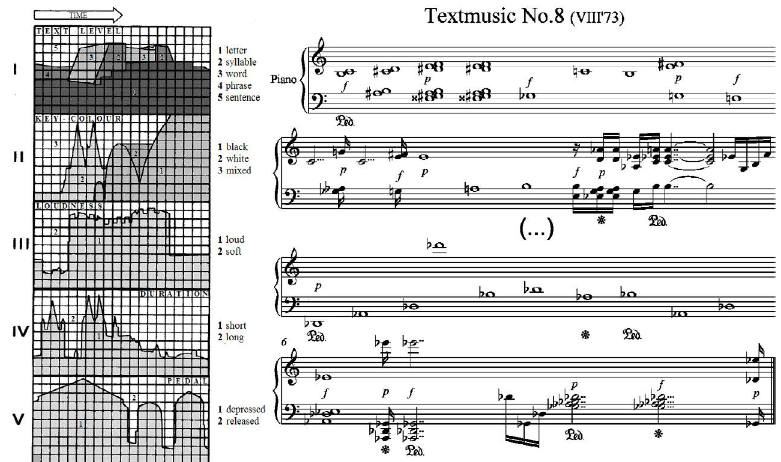
Fig.12: Textmusic for piano (1971) – parametric plan, beginning and end of Version 8 (1973).